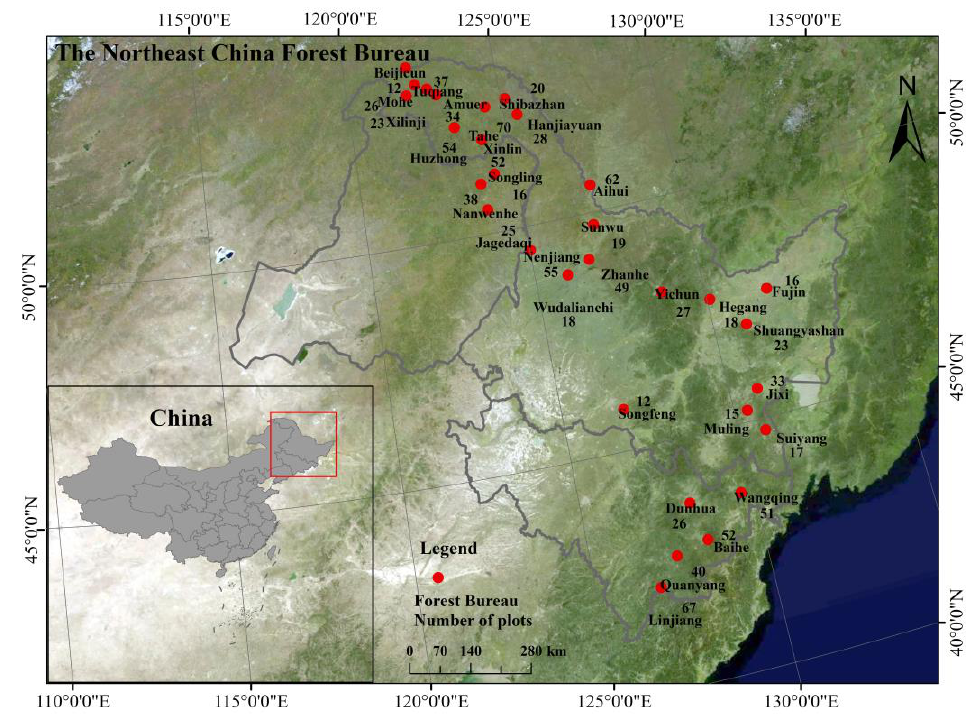
Figure 1. Study area showing the sample plot locations.